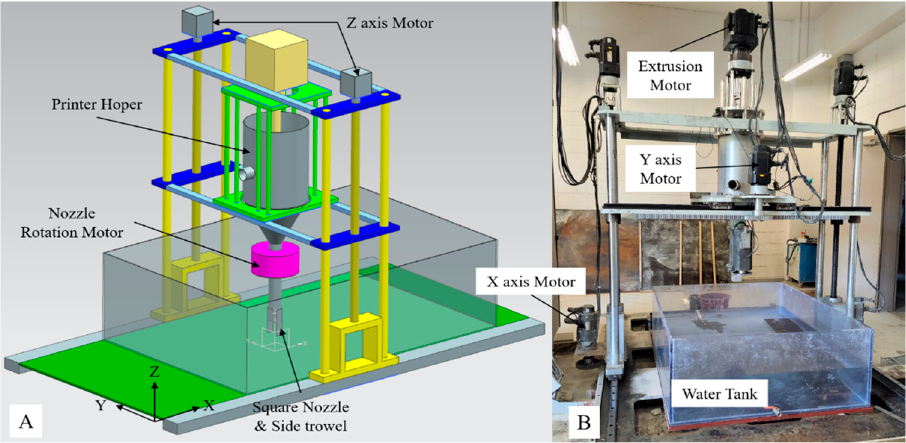
Figure 4. The printing equipment of 3DCP system: ( A ) concept model; ( B ) developed machine. Linear guide rails were used for the X- and Y-axes, and ball screws were used for the Z-axis. The nozzle rotation axis (axis A) was used to rotate a square nozzle using a spur gear. In addition, for WP, the rotating servomotor was equipped with particularly manufactured waterproof